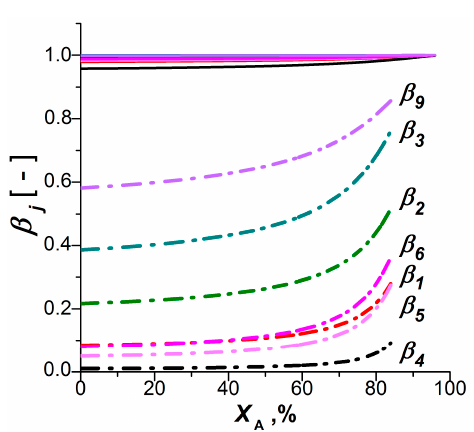
Figure 5. The coefficient β j vs. ethanol conversion X A in PFR . Conditions as in Figure 3. C3-alcohol of 0.001 (solid) and 0.3% mol (dash ‐ dot).